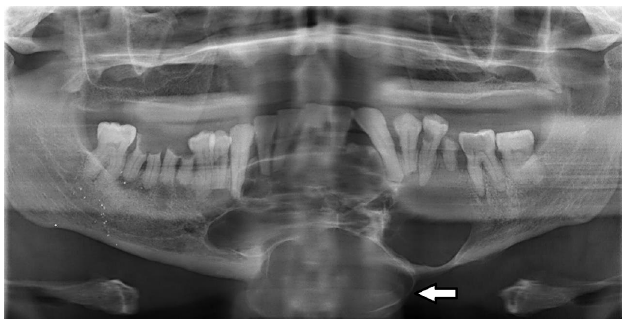
Fig. 2. Multilocular appearance of an ameloblastoma in the anterior and posterior regions of the